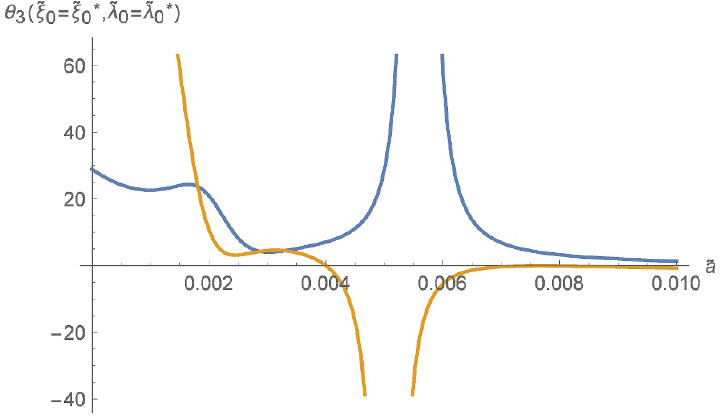
Figure 3 . The behavior of (cid:18) 3 as a function of ~ a . The blue and orange lines correspond to the \EH + R 2 " (i) and (ii),